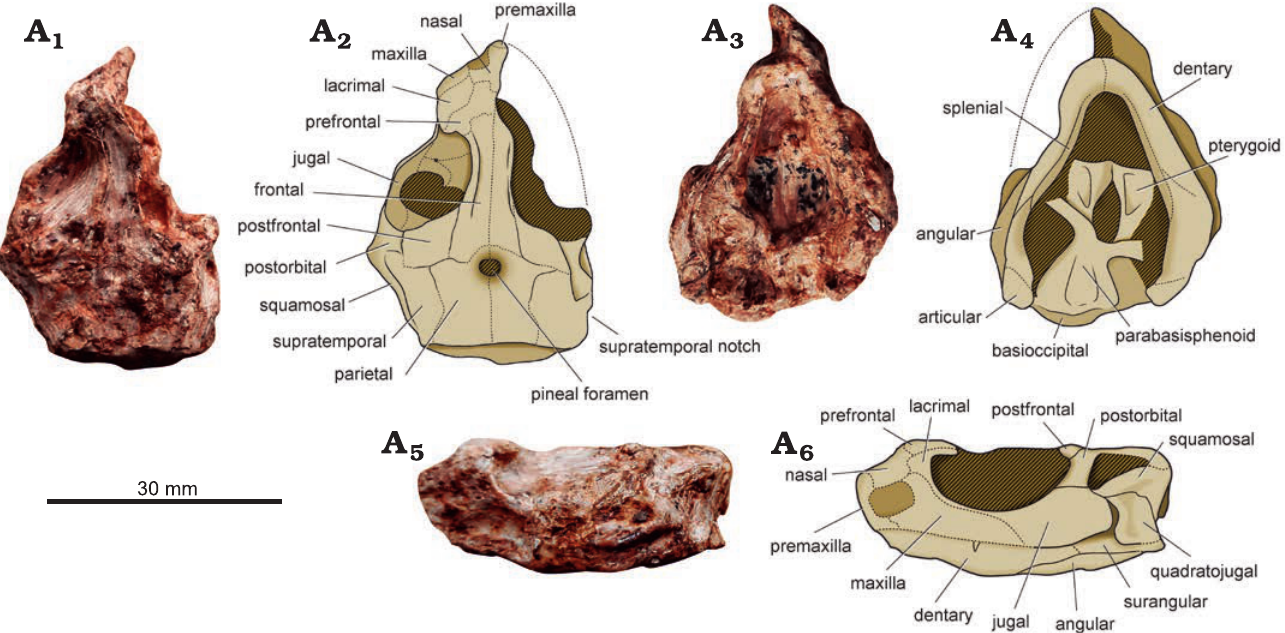
Fig. 3. Owenettid procolophonoid Candelaria barbouri (CAPPA/UFSM 0225) from the “Posto” site, Dona Francisca, Rio Grande do Sul, Brazil; Ladinian, Middle Triassic. Skull and mandible in dorsal (A 1 , A 2 ), ventral (A 3 . A 4 ), and left lateral (A 5 , A 6 ) views. Photographs (A 1 , A 3 , A 5 ) and explanatory drawings (A 2 , A 4 , A 6